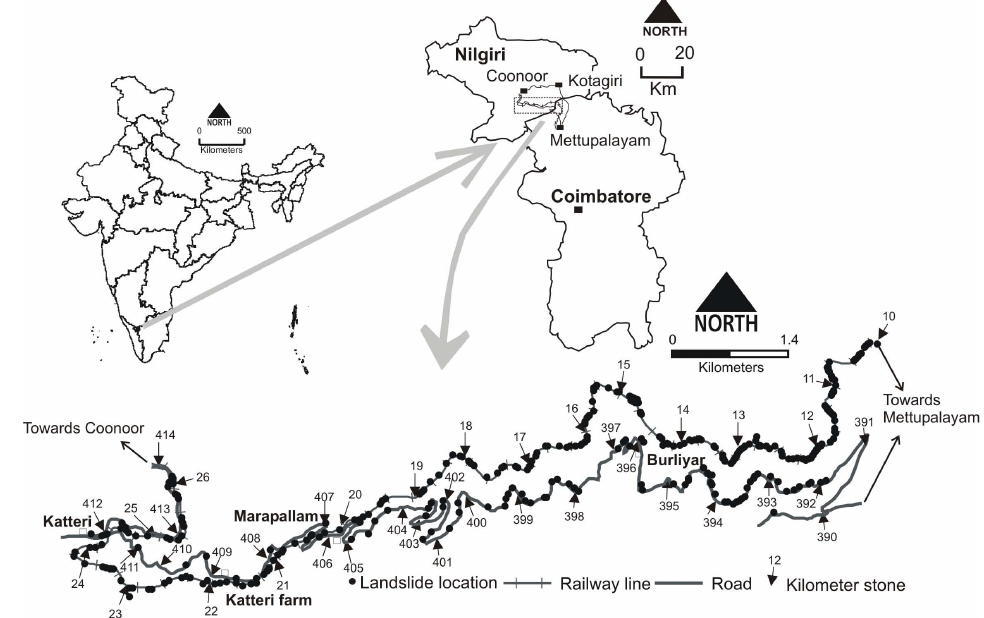
Fig. 1. Location of the road and the railway alignment. Black circles are the location of